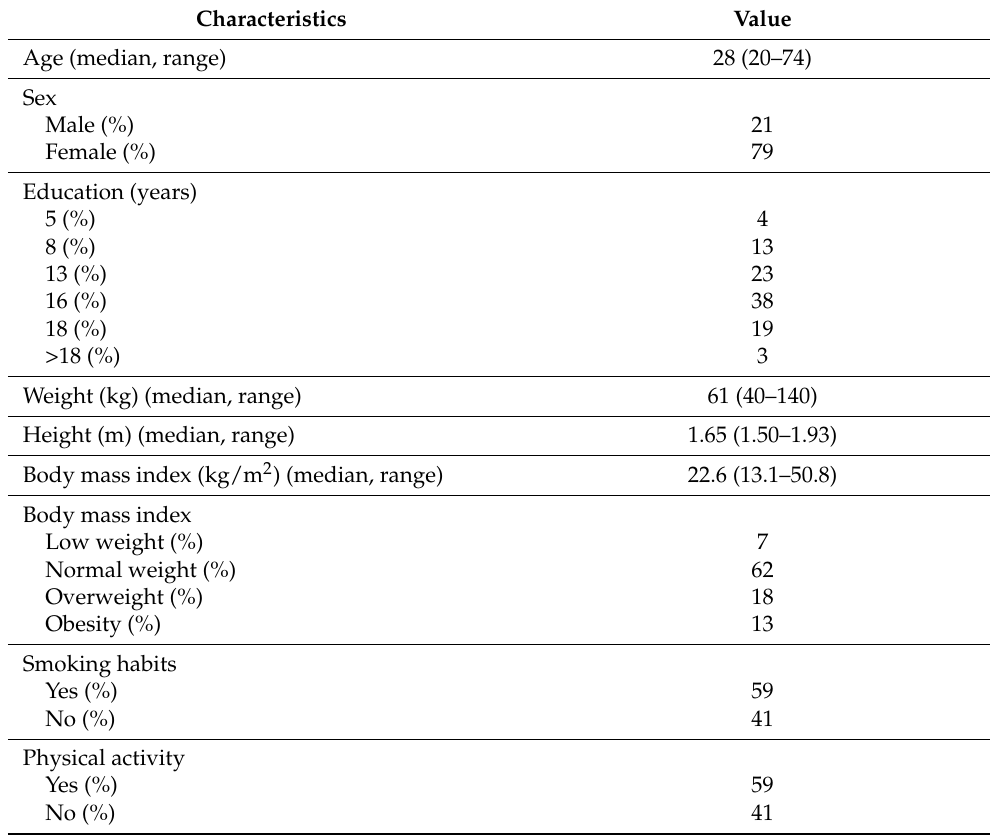
Table 4. Characteristics of the study participants (n =